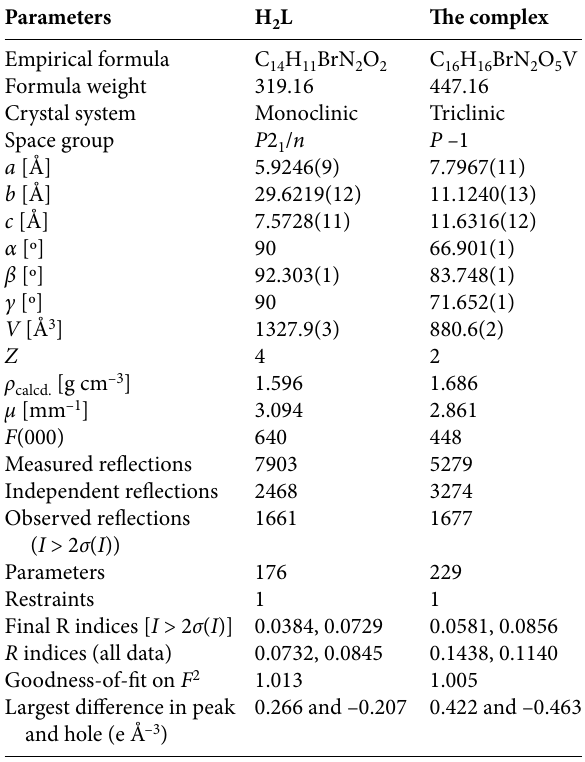
Table 1. Crystallographic Data for H 2 L and the